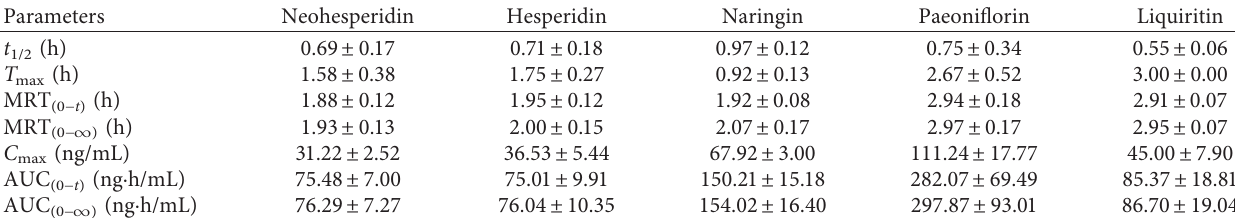
Table 7: Main pharmacokinetic parameters of five analytes after giving a single dose of CHSGS ( n � 6).